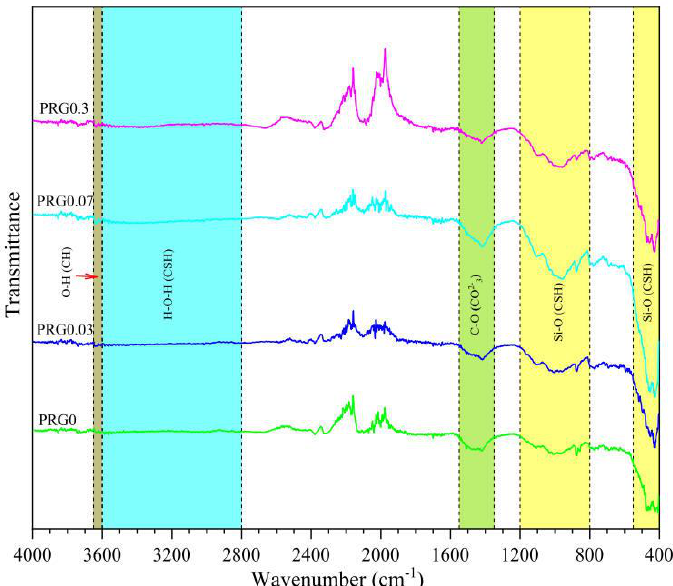
Figure 15. FTIR spectra of cement composites with different graphene concentrations (0%, 0.03%, 0.07% and 0.3%) at 28 days. Reprinted with permission from Ref. [42]. Copyright 2020 Elsevier.